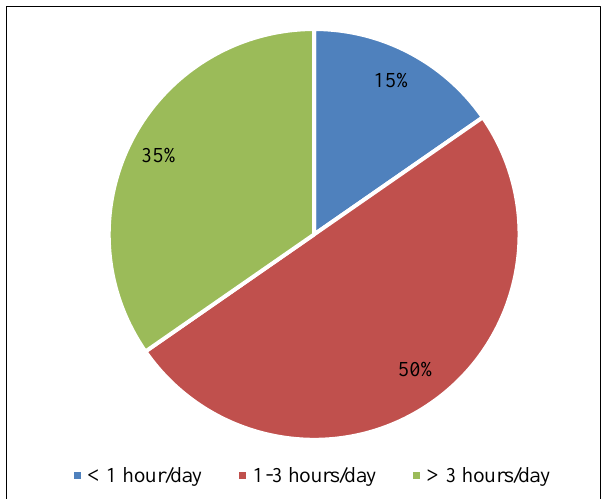
Figure 2. Frequency of using subscription-based movie service